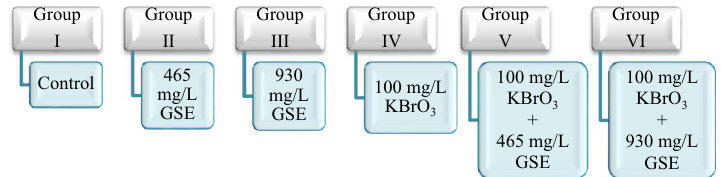
Figure 1. Experimental groups. GSE: grape seed extract, KBrO 3 : potassium